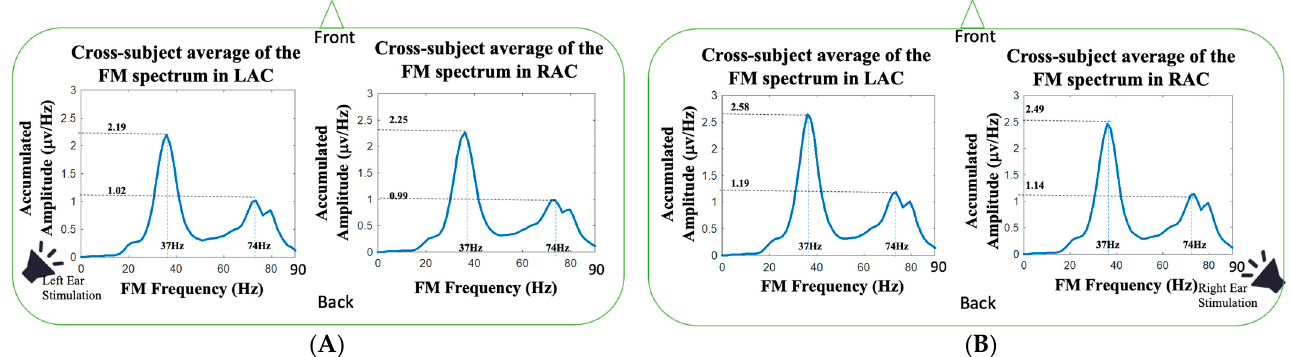
Figure 4. The FM spectra averaged across the twenty-five subjects in our study: ( A ) The cross-subject average of FM spectrum in LAC and RAC during left-ear auditory stimulations; ( B ) the cross-subject average of FM spectrum in LAC and RAC during right-ear auditory stimulations.